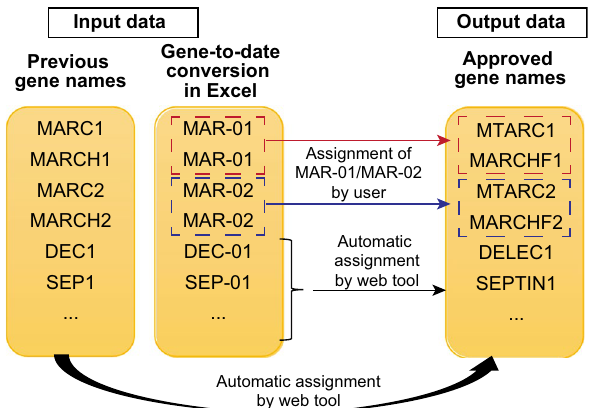
Figure 1. Schematic of Gene Updater. If old gene names are provided, these genes will be automatically converted to the updated approved gene names. If dates are provided, all genes, with the exception of MAR-01 and MAR-02 will be converted to the new approved gene names. For MAR-01 and MAR-02, users can assign the genes to either MTARC1, MARCHF1, MTARC2 or MARCHF2 within Gene